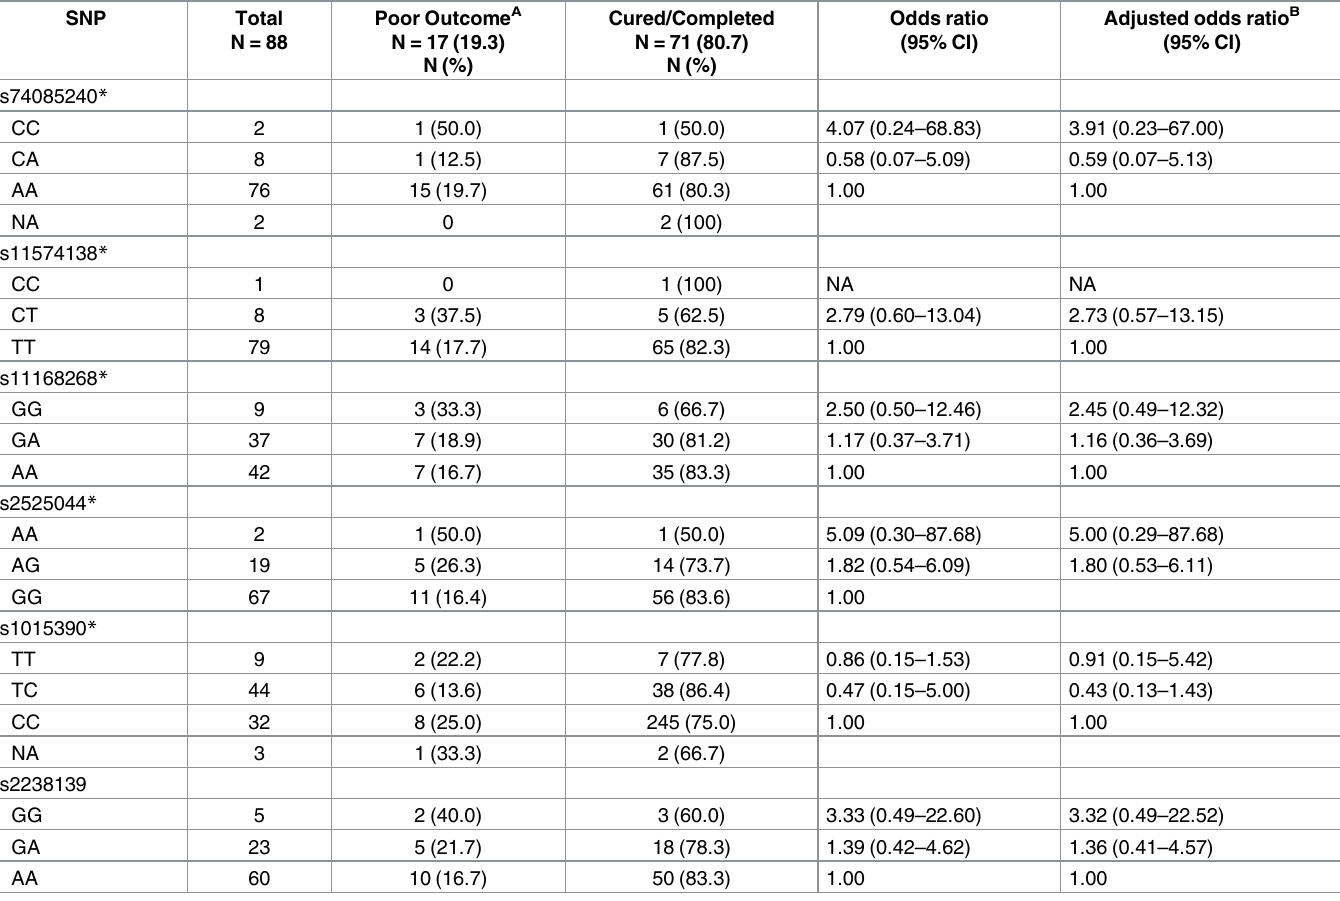
Table 3. Poor tuberculosis treatment outcome by vitamin D receptor gene single nucleotide polymorphism, N = 88.